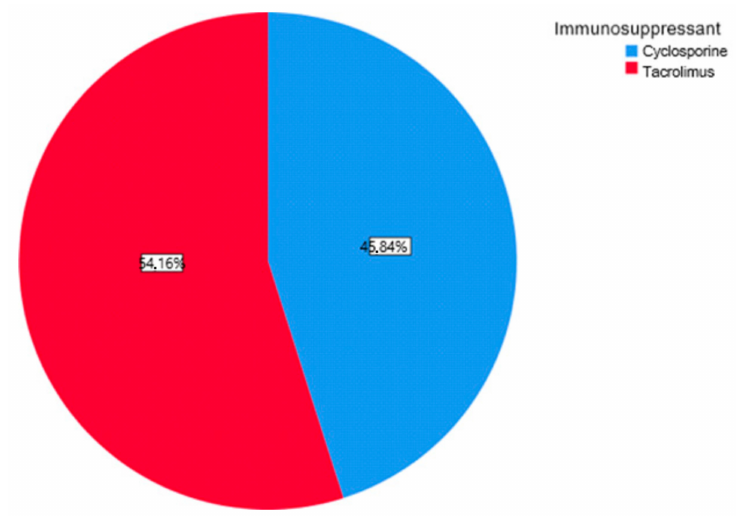
Figure 1. Percentage distribution of immunosuppressive treatments.